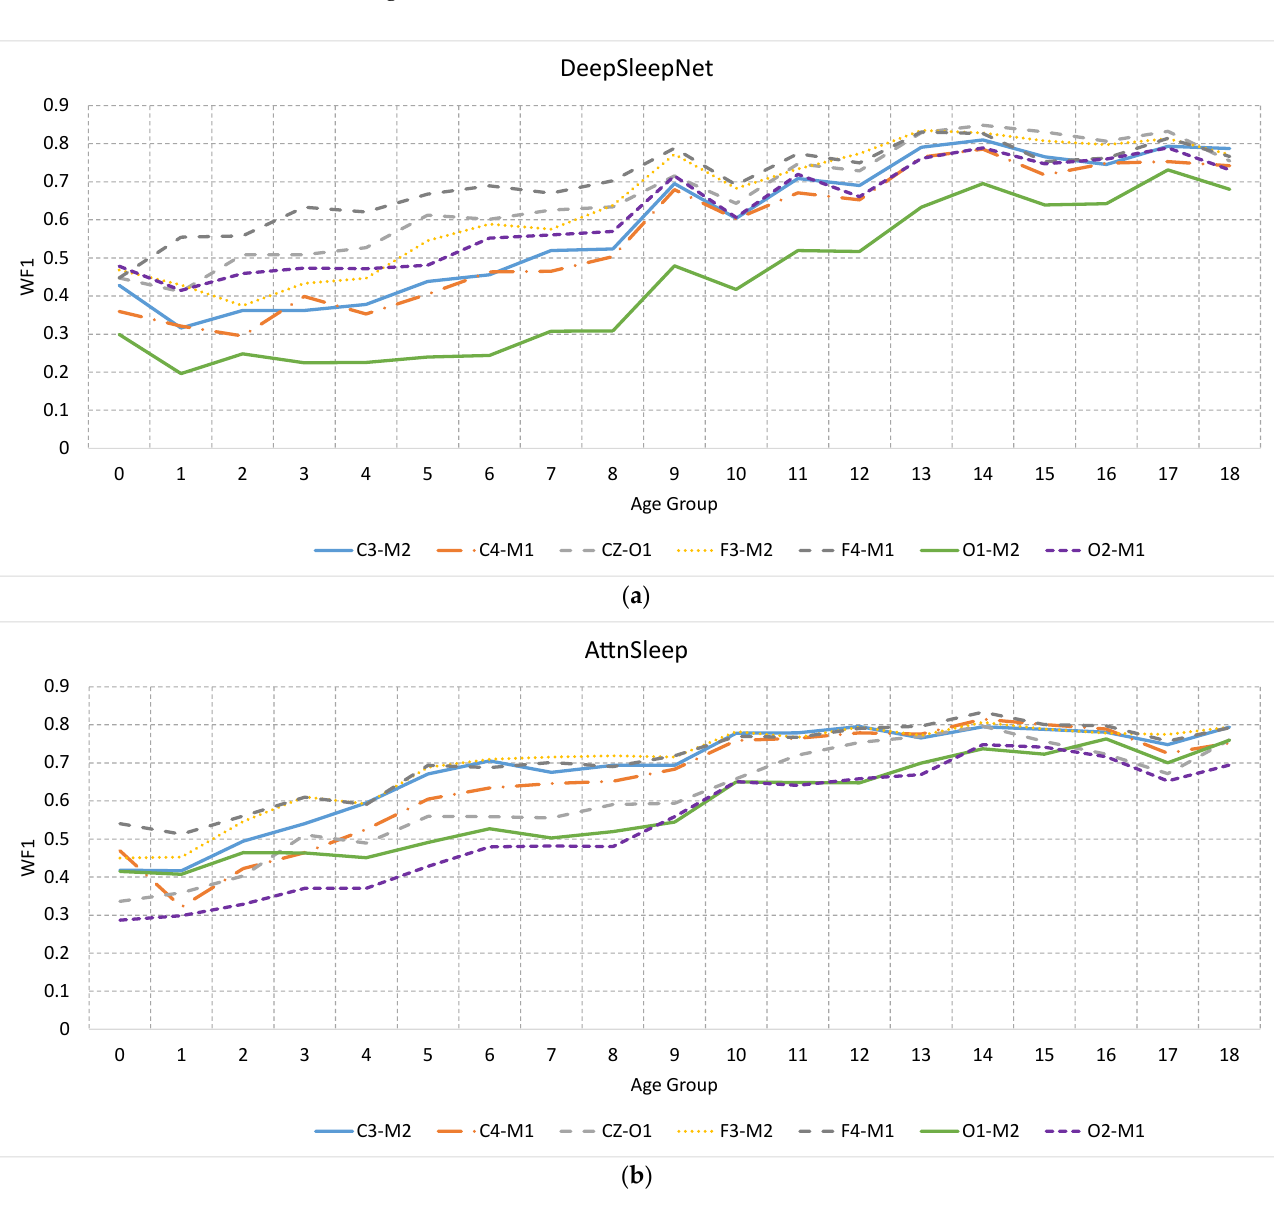
Figure 8. The performance of a model trained on adult EEG signal over different age ranges using different channels for ( a ) DeepSleepNet and ( b ) AttnSleep methods. As seen, the model had the lowest WF1 score when tested against infant EEG signal and increased gradually with the increase of the participants’ age.